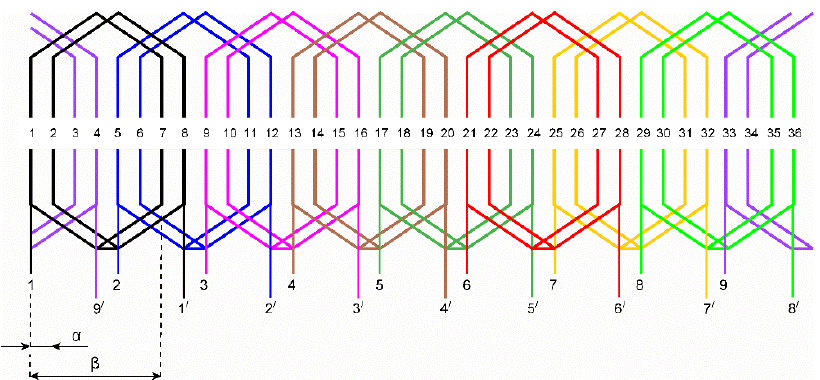
Figure 5. Arrangement of the first type of nine-phase winding ( S = 1, M = 9, c g = 2, α = 360/ Z s = 360/36 ≈ 10°, β = 6 α = 60°); beginnings of the phase windings: 1, 2, 3…; endings of the phase windings: 1 ′ , 2 ′ , 3 ′ , …